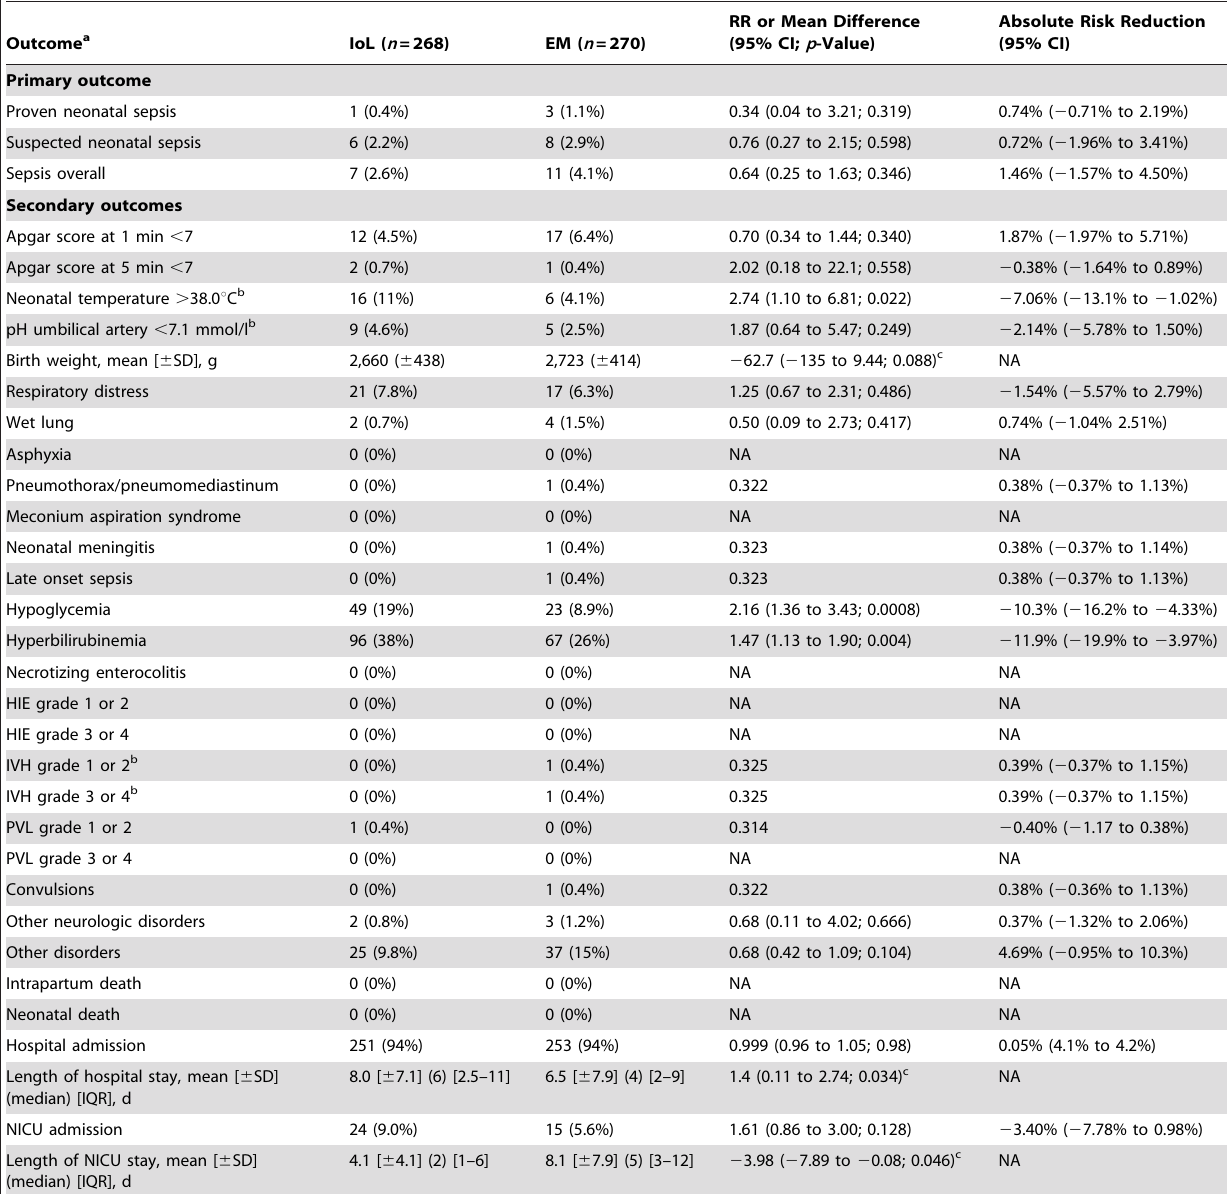
Data are presented as number (percent) unless otherwise indicated. a Percentages, RRs, 95% CIs, and p -values given according to available data. b Outcome characteristic with more than 5% missing data. Neonatal temperature data available for 292 infants (54%); pH umbilical artery data available for 397 (74%); intraventricular hemorrhage data available for 508 (94%). c Mean difference with 95% CI. HIE, hypoxic ischemic encephalopathy; IQR, interquartile range; IVH, intraventricular hemorrhage; NA, not applicable; PVL, periventricular leucomalacia; SD, standard deviation. (3.3%) for maternal hypertensive disorders, and in two (2.2%) for other maternal complications. In the remaining two patients (2.2%), no reason for induction was recorded. Figure 2 shows the Kaplan-Meier curve for the interval between randomization and delivery in both groups.